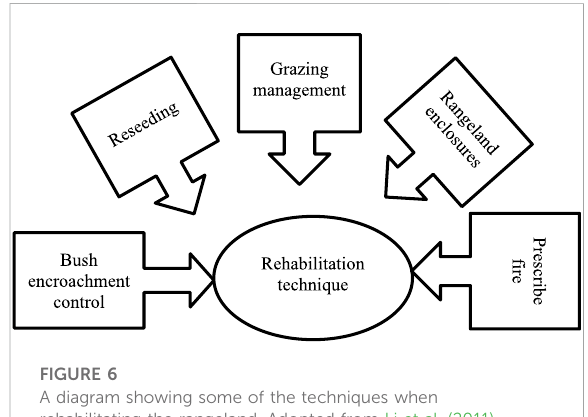
FIGURE 6 A diagram showing some of the techniques when rehabilitating the rangeland. Adopted from Li et al.